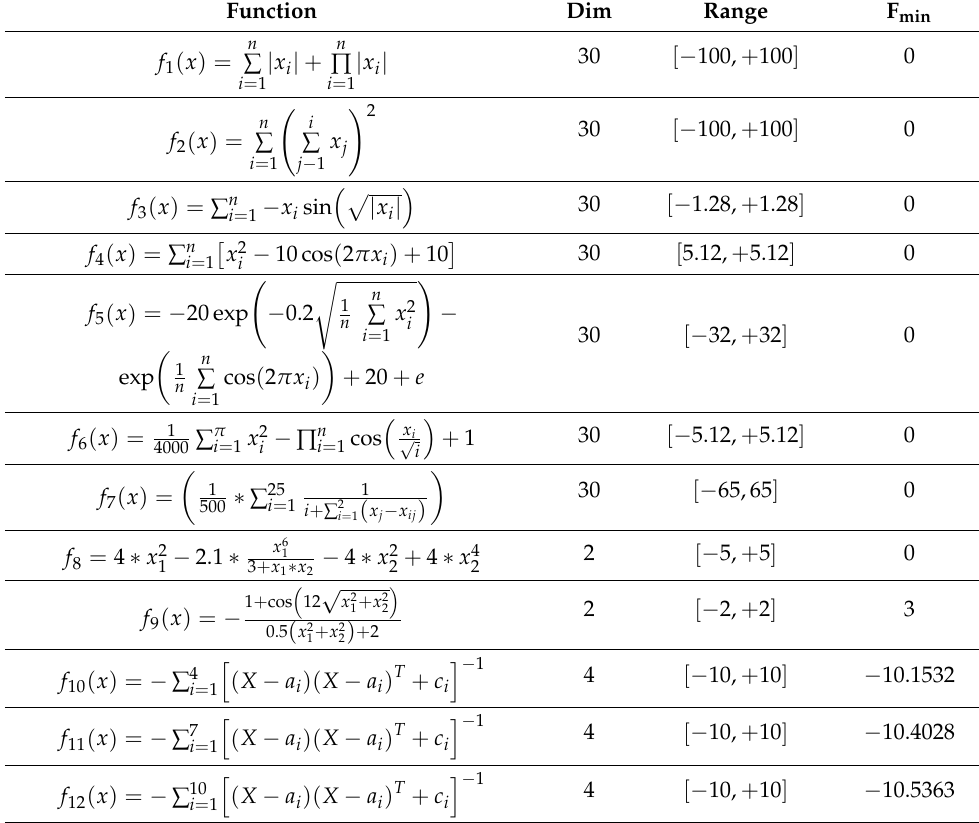
Table 1. The 12 benchmark functions.